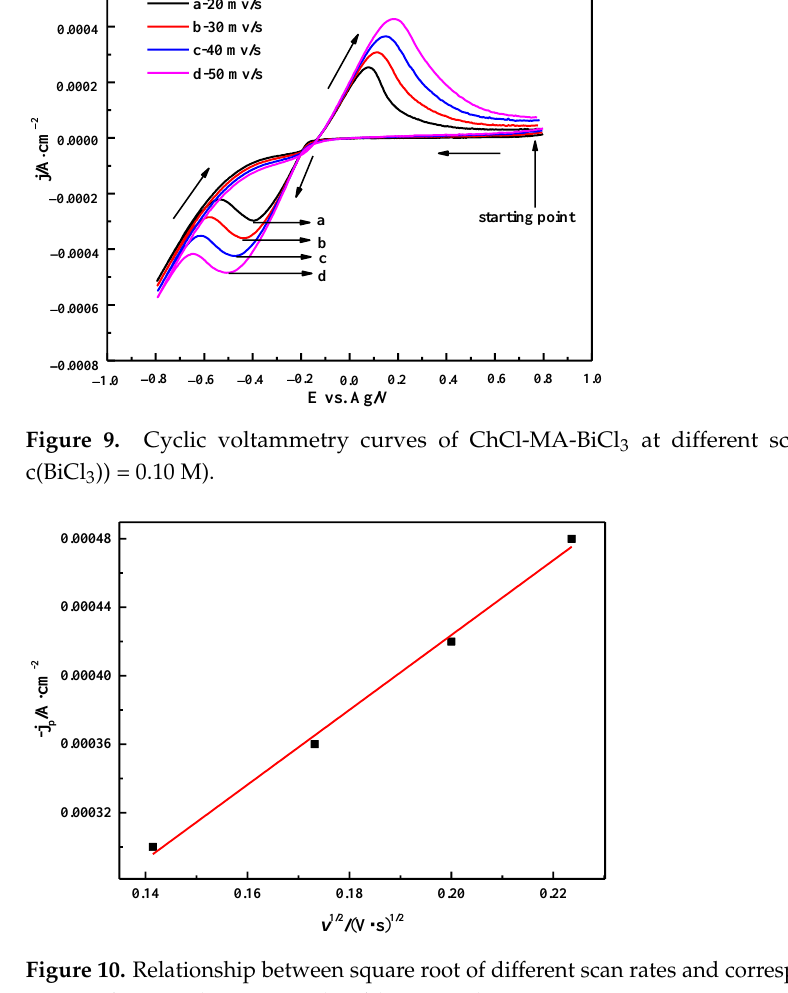
Figure 10. Relationship between square root of different scan rates and corresponding cathodic peak current densities (T = 343 K, c(BiCl 3 ) = 0.10 M).